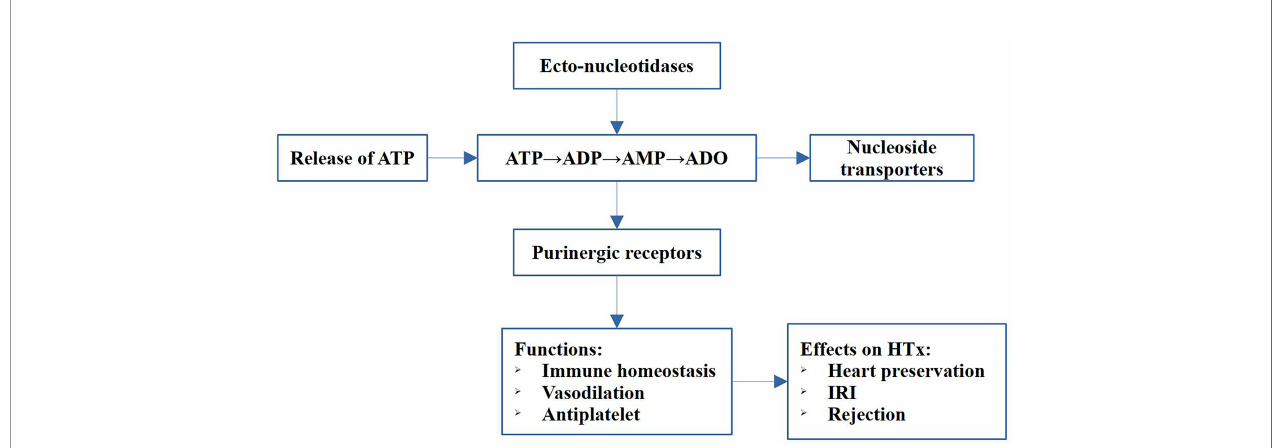
FIGURE 1 | Schematic diagram of the strategy of the study. The main components of the purinergic signaling includes release of ATP, the hydrolysis of ATP to adenosine, the ecto-nucleotidases, transporters and purinergic receptors. The purinergic signaling exert immune regulation, vasodilation and antiplatelet functions, and play pivotal roles in heart preservation, IRI and rejection in heart transplantation